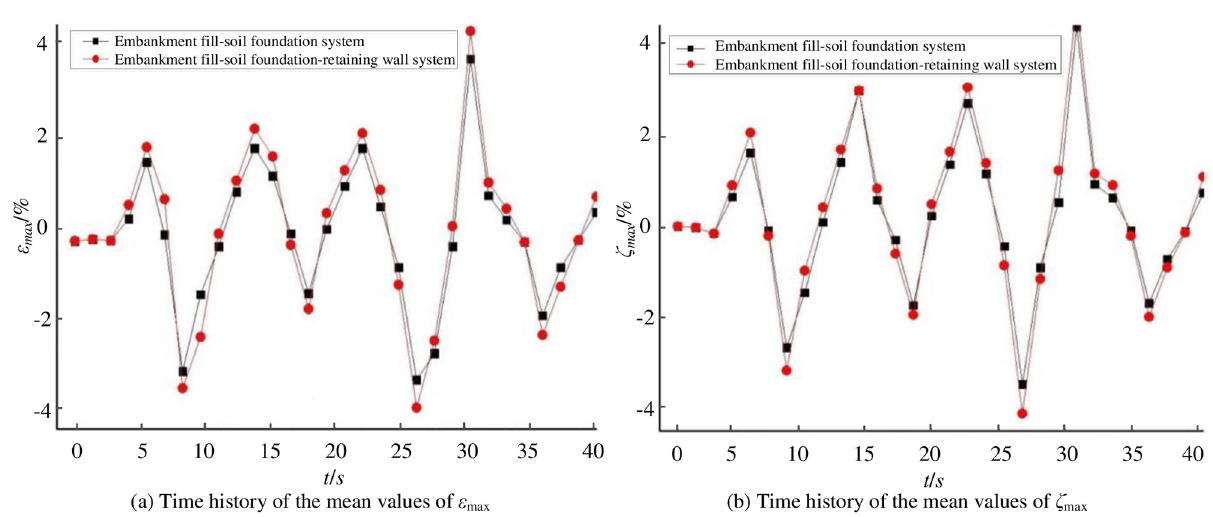
Fig 4. Time histories of the mean values of ε max and z max (positive values represent subsidence, negative values represent tilt).